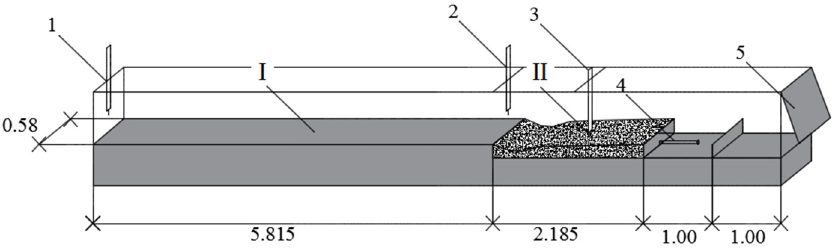
Figure 4. Experimental channel scheme (all dimensions in meters). Where: I—solid bottom; II— washout bed (sandy); 1,2—pin water gauge; 3—disc probe; 4—collection chamber; 5—the regulatory gate.